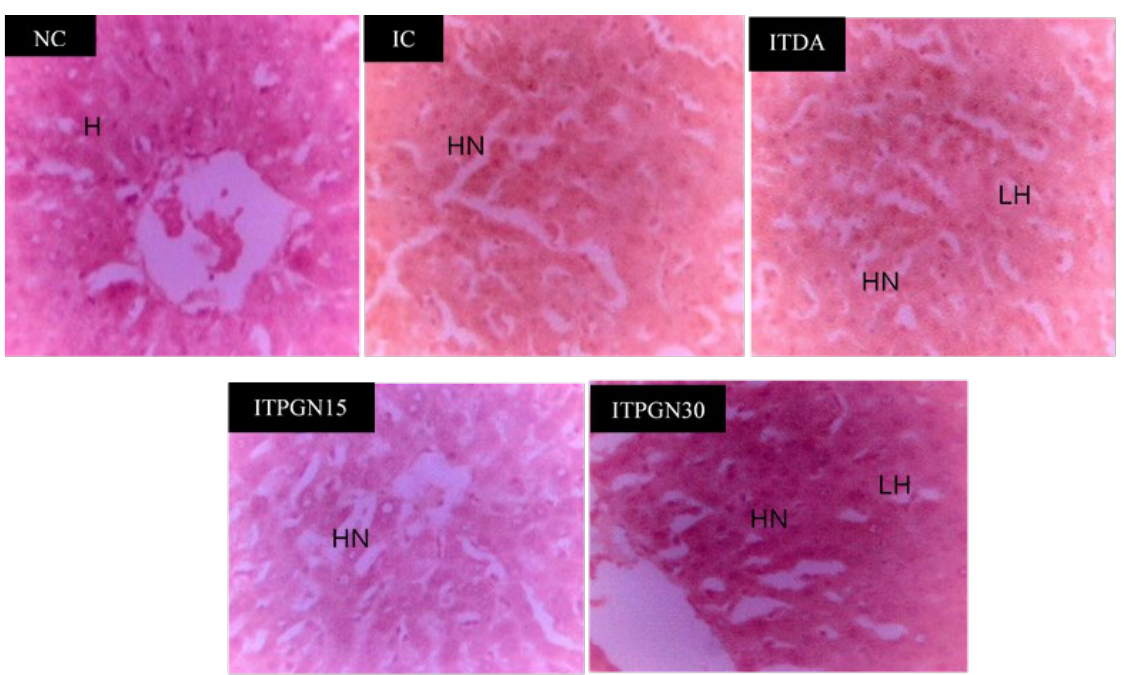
Figure 5. Liver histopathology of T. congolense -infected rats treated with different doses of phloroglucinol . H = Hepatocytes Normal, HN = Hepatocellular Necrosis, LH = Lymphocyte Hyperplasia. NC = Normal control, IC = Infected control, ITPGN15 = Infected + 15 mg/kg BW PGN, ITPGN30 = Infected + 30 mg/kg BW PGN, ITDA = Infected + 3.5 mg/kg BW DA.